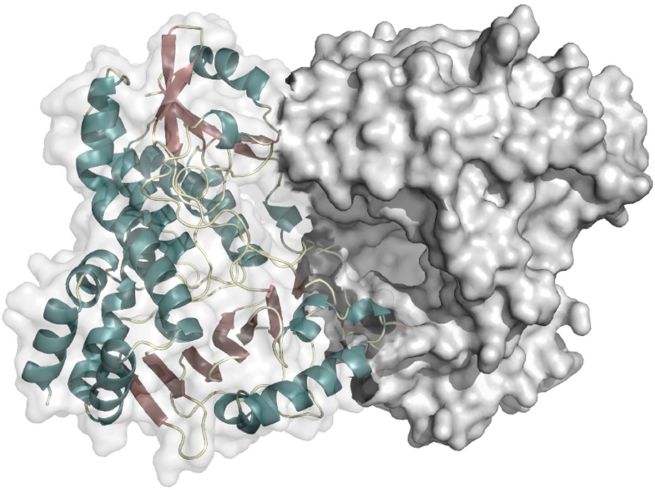
Figure 7. Structure of head-to-tail styrene monooxygenase dimer (PDB ID: 3IHM). Coloring is according to secondary structure: helices (deep teal), sheets (brown) and loops (pale yellow). The surface of the left monomer is indicated transparently [151]. Biology 2018 , 7 , x